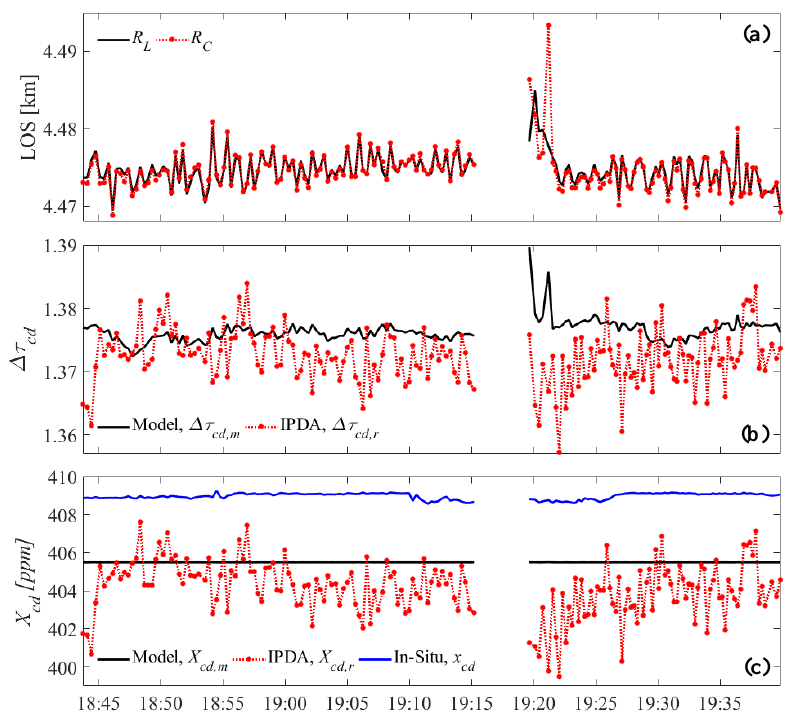
Figure 15. Airborne pulsed 2-μm IPDA lidar measurement and retrieval results during Ocean 1 and Ocean 2 records obtained before and after sunset. ( a ) Airborne LOS, R L as compared to IPDA column measurement, R C . ( b ) IPDA Δ τ cd measurement using 10-s (500 shots) average compared to model Δ τ cd obtained from MGD. ( c ) IPDA retrieved XCO 2 , X cd,r , compared to model driven XCO 2 , X cd,m and corresponding x cd in situ measurements. Measurements obtained using 3 GHz and 8 V e-APD bias.